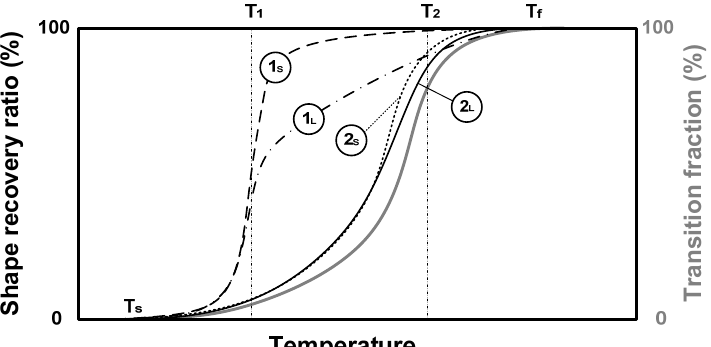
Figure 18. Illustration of shape recovery ratio/transition fraction against heating temperature. The designated 1 is programmed at T small deformation and subscript L stands for large deformation. (Modified from